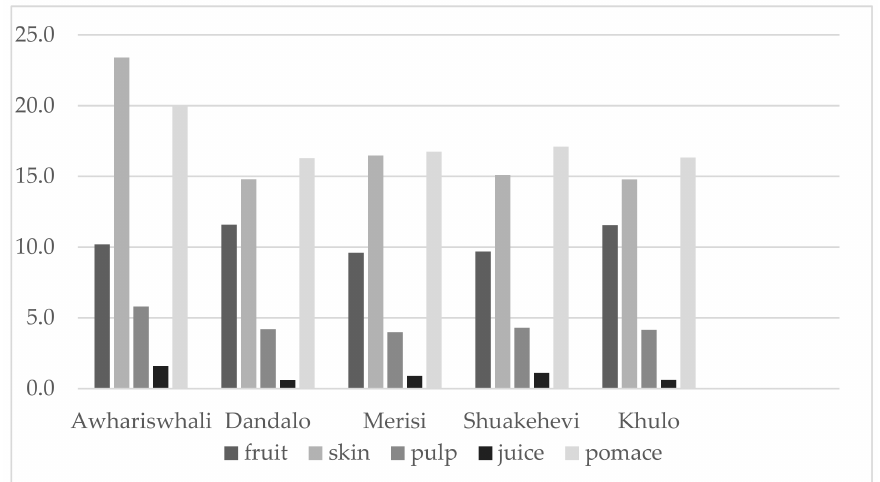
Figure 4. Antioxidant activity of the different parts of the fruits from five different villages.